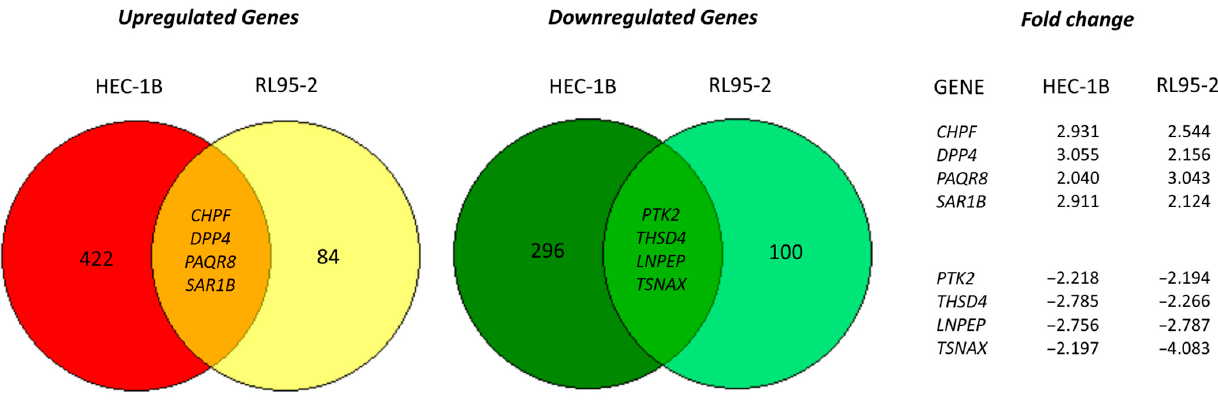
Table 2. Top 10 regulated genes after RNAi-mediated knockdown of DSCAM-AS1 in HEC-1B and RL-95-2 cells ( p < 0.05). The knockdown efficacy differed between both cell lines due to ER α - triggered DSCAM-AS1 upregulation in RL95/2 cells. FC = fold-change. Genes Regulated upon DSCAM-AS1 Silencing (Top 10) HEC-1B RL95-2 Gene Symbol Gene Name FC Gene Symbol Gene Name FC ets homologous SCEL sciellin − 5.99 − 3.14 TMC7